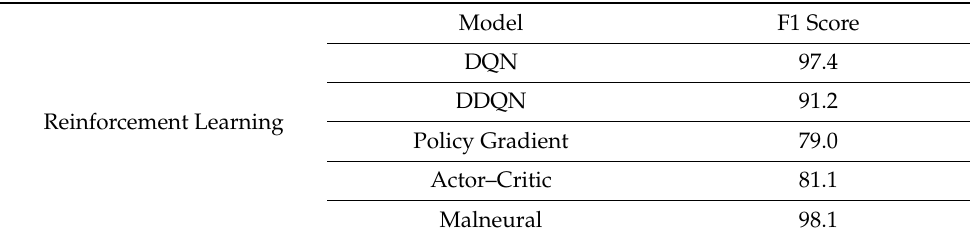
Figure 21. Analysis of reinforcement learning algorithm for the classification of monkeypox. Table 10. F1 score calculation for detection of monkeypox disease detection results using the rein- forcement learning